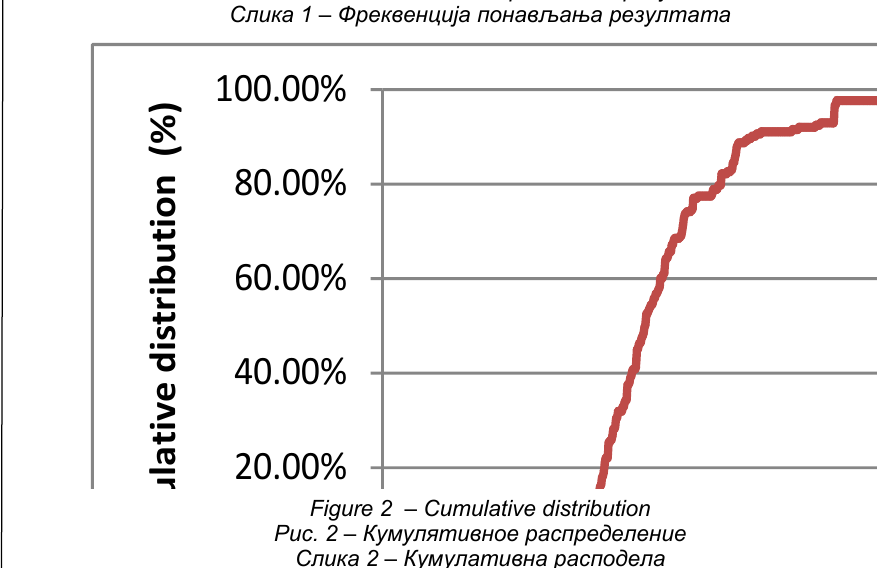
Figure 2 – Cumulative distribution Рис . 2 – Кумулятивное распределение Слика 2 – Кумулативна